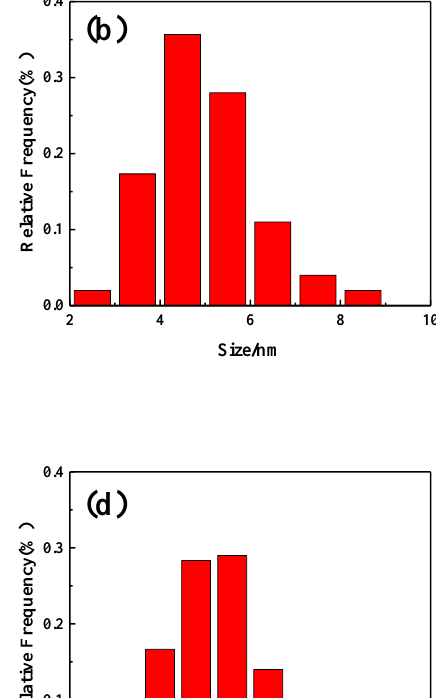
6 of 14 . Figure 3. SEM images (ED – TD plane) and EDS results of alloys with different Zn/Mg ratios; ( a , d ) 11.4; ( b , e ) 8.1; ( c , f ) 6.1. Figure 4a,c,e show the TEM images of precipitated phases in alloys with different Zn/Mg ratios and the electron incident direction was < 100 > Al . After the T6 heat treatment, short rod-shaped second phase particles precipitated uniformly in grain interior. It can be estimated as η’ phase from the selected area electron diffraction (SED) map. The number density of precipitates was counted by Image J software. Results showed that the number density of η’ phases in the grain interior significantly increased with the decrease of the Zn/Mg ratio. For the Zn/Mg ratio was 11.4, 8.1 and 6.1, the number density of η’ phases is 66,521 μm -2 , 87,863 μm -2 and 118,142 μm -2 , respectively. The